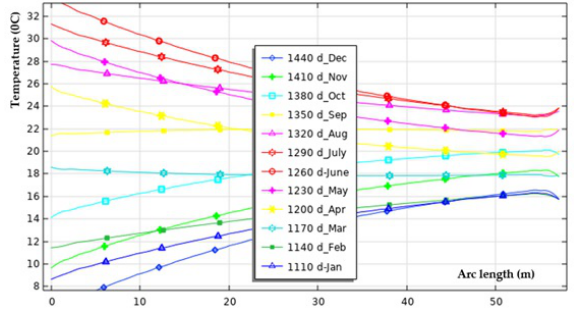
Fig. 10. Distribution of air temperature in the pipe